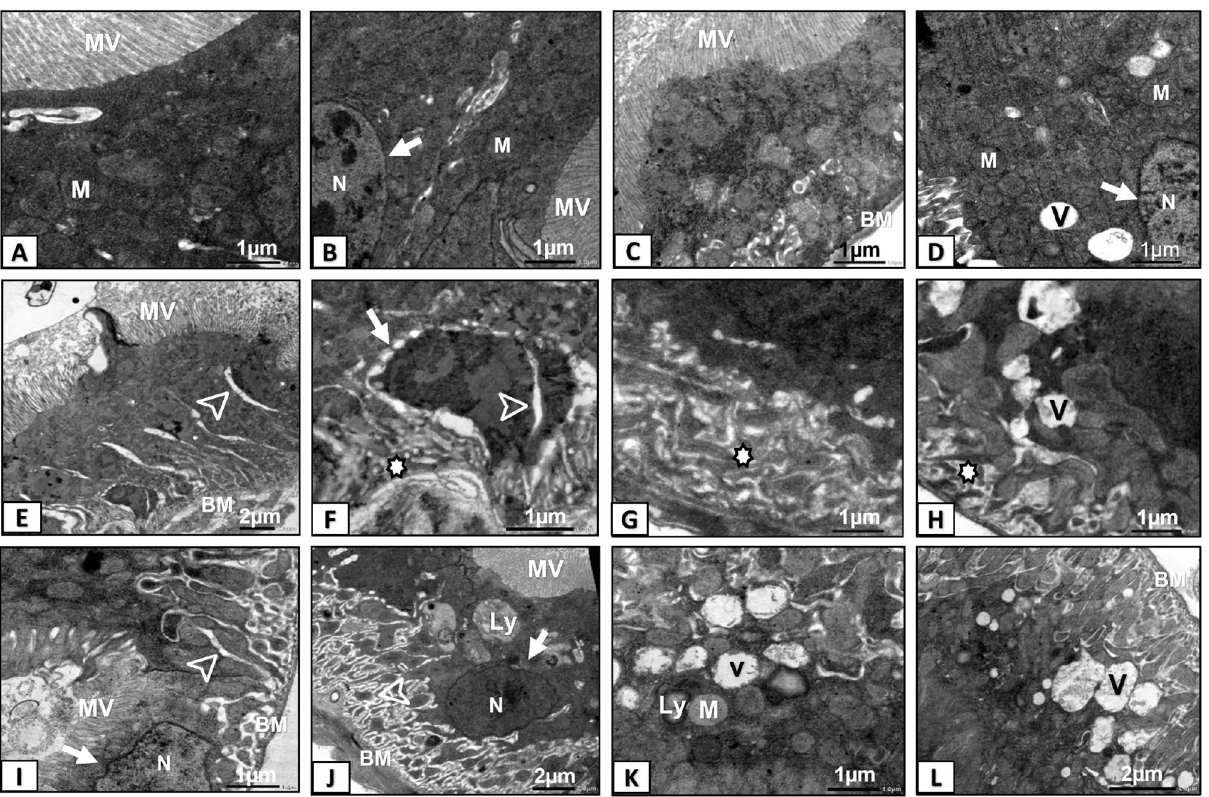
Figure 7. Transmission electron microscopy photomicrographs of mid gut cells of adult D. melanogaster flies that fed on food media-supplemented with different concentrations of green-yellow, fluorescent polystyrene microplastics (PS-MPs) for 7 days. ( A , B ) Control group, exhibiting typical morphology of columnar cells with the apical border straight and bearing numerous, long filament like microvilli. ( C , D ) flies fed 0.005 µg/ ml of PS-MPs, showing comparable cellular structure like control group with only some vacuoles. E–H flies fed 0.05 µg/ml of PS-MPs. Note, intracellular cleft which also appeared within the nucleus (arrowhead), vacuolated cellular membrane (white arrow), abnormal folding of basement membrane (star) and vacuoles. I-L flies fed 0.5 µg/ml of PS-MPs. Note cracks or intercellular cleft, indentation in the nuclear membrane (white arrow), lysis of matrix and breakage of mitochondrial cristae, lysosomes engulf PS-MPs and large vacuoles N Nuclei; MV microvilli; M mitochondria; BM basement membrane; Ly lysosomes; V